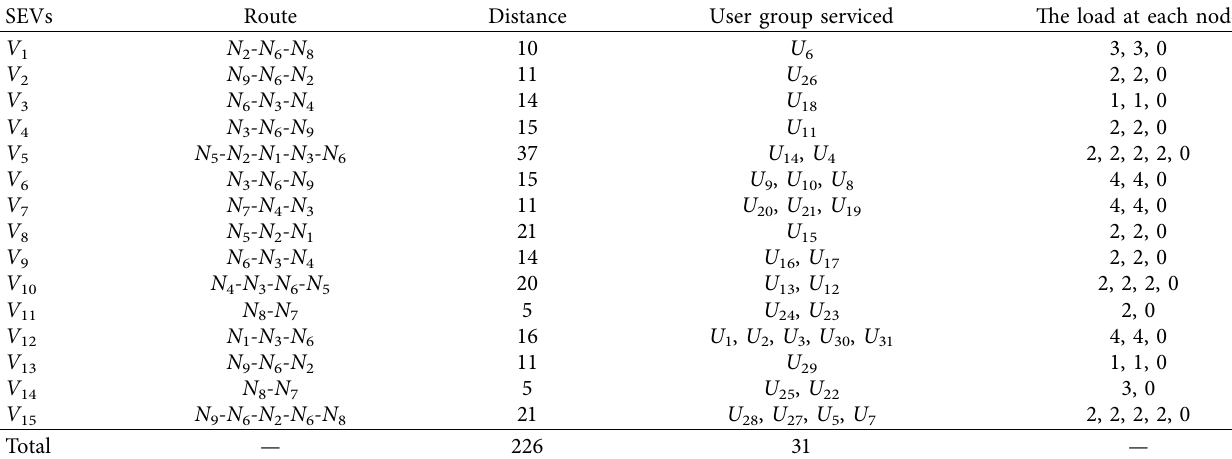
Table 3: SEVs and their routes for the users in MSEVRS.